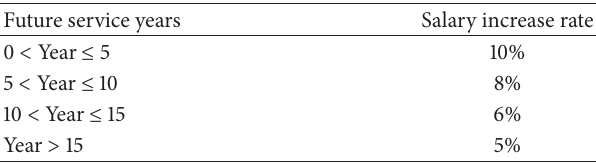
Table 2: Assumption of salary increase